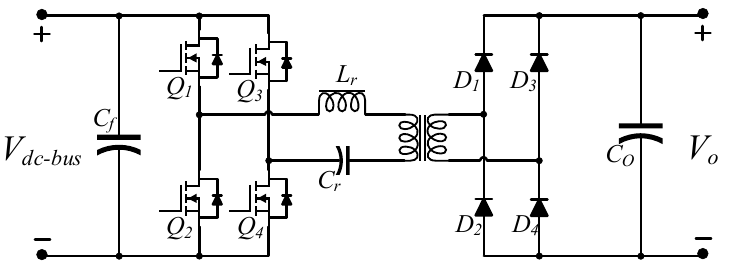
Figure 20. Full-bridge LLC resonant Figure 20 . Full-bridge LLC resonant converter.